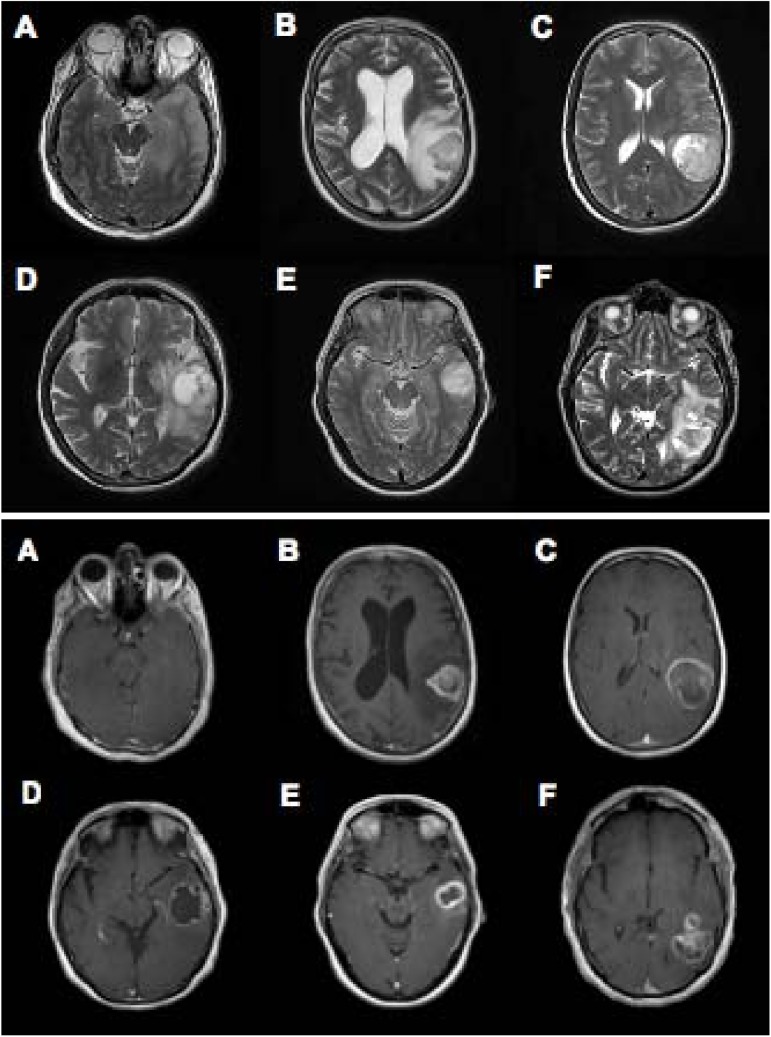
Preoperative MR Imaging.Representative axial slices demonstrating preoperative T2 weighted (upper panel) and contrast enhanced T1 weighted (lower panel) MR imaging demonstrating intracranial neoplasm in each patient.